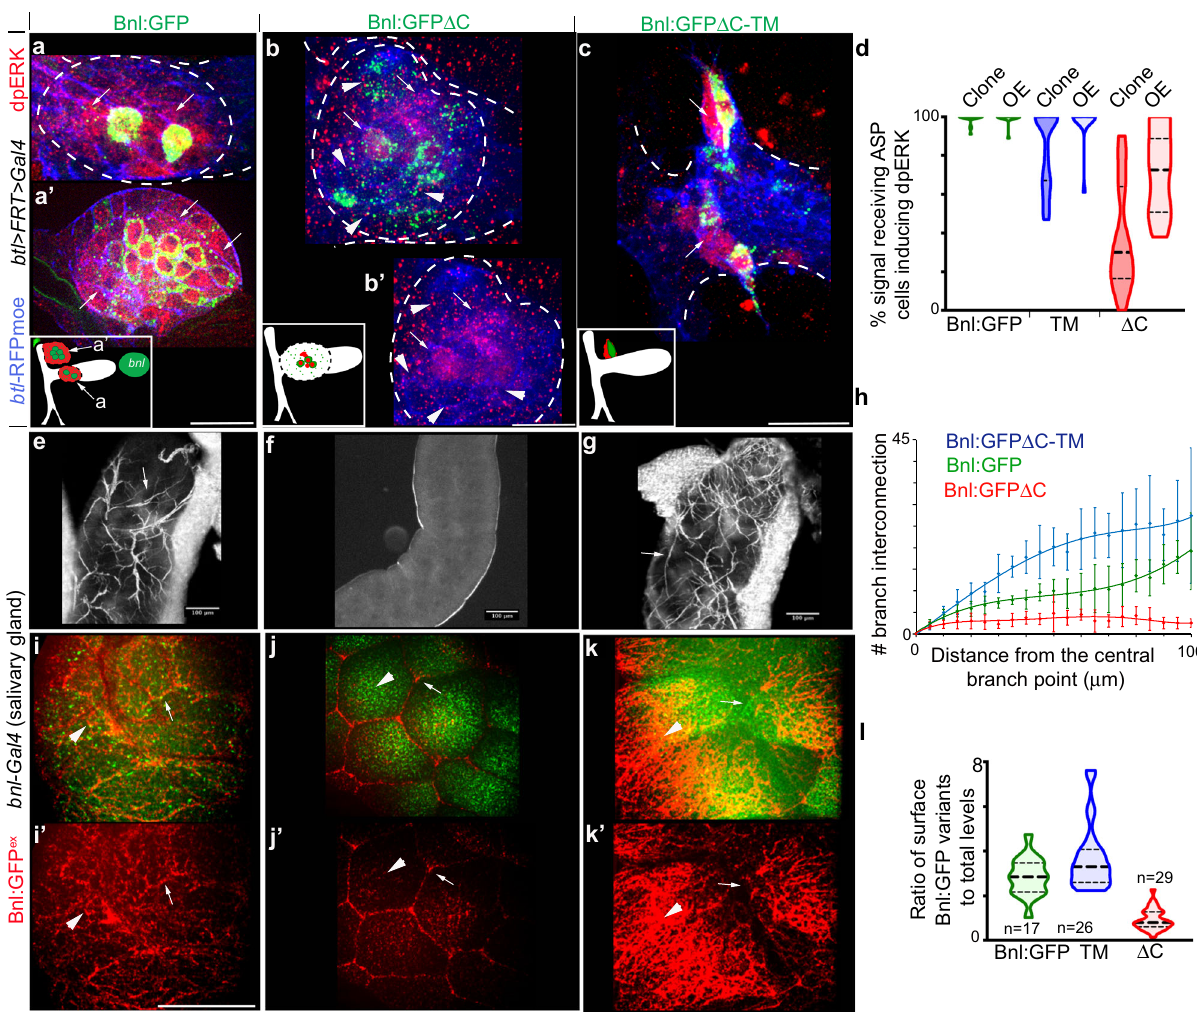
Fig. 9 GPI-anchored Bnl promotes recipient-speci fi c patterning. a – c Comparison of non-autonomous signaling (dpERK, red; arrows) patterns of Bnl:GFP (control), Bnl:GFP Δ C, and Bnl:GFP Δ C-TM, expressed from ectopic GOF clones within the ASP stalk and TC; approximate clone locations and dpERK patterns indicated in inset; arrow and arrowhead, signal-recipient cells with and without nuclear dpERK, respectively; genotype: hsFlp ; btlenh > y + >Gal4,btlenh-mRFPmoe x UAS- “ X ” . d Violin plots comparing the percentage of signal-receiving ASP cells with nuclear dpERK; clone, clonal expression; OE, overexpression ( bnlGa4 x UAS-X ; see Supplementary Fig. 7h – k); for OE: p < 0.01 for Δ C ( n = 16) vs either Bnl:GFP ( n = 17) or TM ( n = 13) (one-way ANOVA followed by Tukey HSD test); for clonal analyses: see Supplementary Fig. 7g for statistics. e – h Levels of tracheal branch invasion (arrows) into larval salivary glands ectopically expressing either Bnl:GFP (control), TM, or Δ C under bnl-Gal4 ( bnl-Gal4 X UAS-X ); e – g bright fi eld images, ×10 magni fi cation. h Graphs showing mean frequency (±SD) of terminal branching (see Methods); n , number of tissues analyzed per genotype: 5 (TM), 6 (Bnl:GFP), 4 ( Δ C). i – l Levels of Bnl:GFP, TM, and Δ C displayed on the basal surface of the expressing salivary glands; arrow, cell junctions. l Violin plots comparing the fraction of surface-displayed signals (red/arrowhead, α GFP ex ) to total protein expressed (GFP level); n , number of salivary glands; p < 0.05: Bnl:GFP vs. TM, p < 0.01: Δ C vs. either Bnl:GFP or TM (one-way ANOVA followed by Tukey HSD test). Violin plots, black dotted lines show the median as well as 25 th and 75 th percentiles. Source data are provided as a Source data fi le. Scale bars, 30 μ m; 100 μ m ( e – g ); 20 μ m ( i – k ′